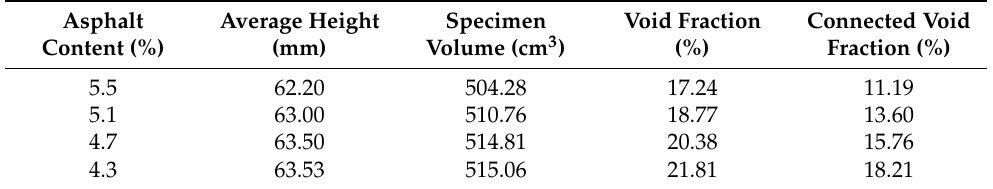
Table 2. EPA-13 measured volume parameters of the Marshall test.